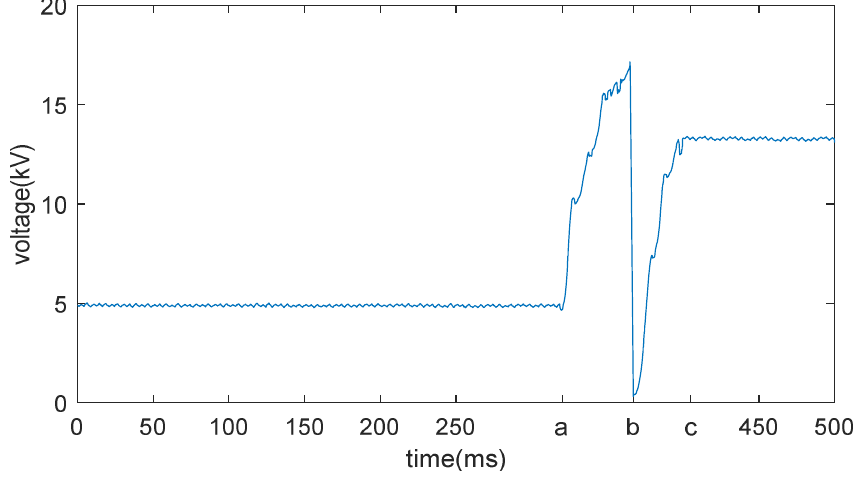
Figure 3. Time history of the voltage across the capacitor.